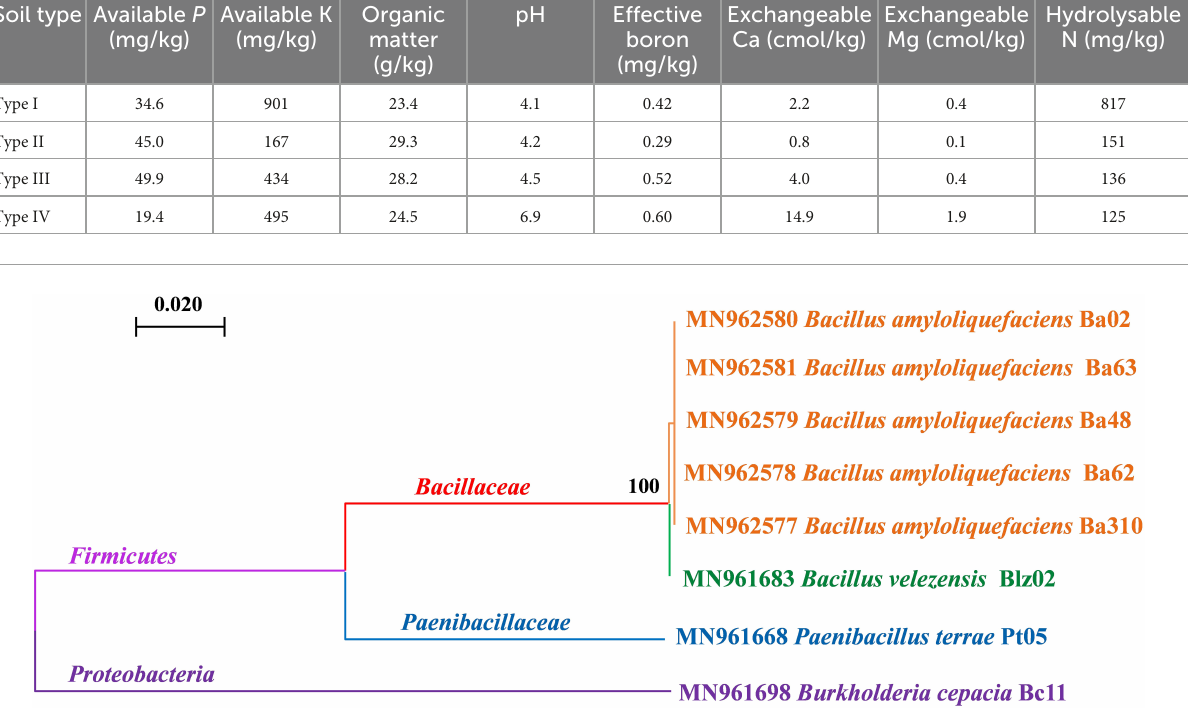
FIGURE1 Evolutionary relationships of biocontrol bacteria. Phylogenetic analyses were conducted by maximum likelihood using the 16s rDNA sequences, which showed the genetic relationship between Bacillus amyloliquefaciens , Bacillus velezensis , Paenibacillus terrae , and Burkholderia cepacia . The numbers represent the accession numbers in GenBank. The confidence probability of each node was estimated using a bootstrap test (1,000 replicates). The scale bars represent a genetic distance of 0.02 substitutions per nucleotide position. All strains were labeled with different colors: orange was B . amyloliquefaciens , green was B . velezensis , blue was P . terrae , and purple was B . cepacia